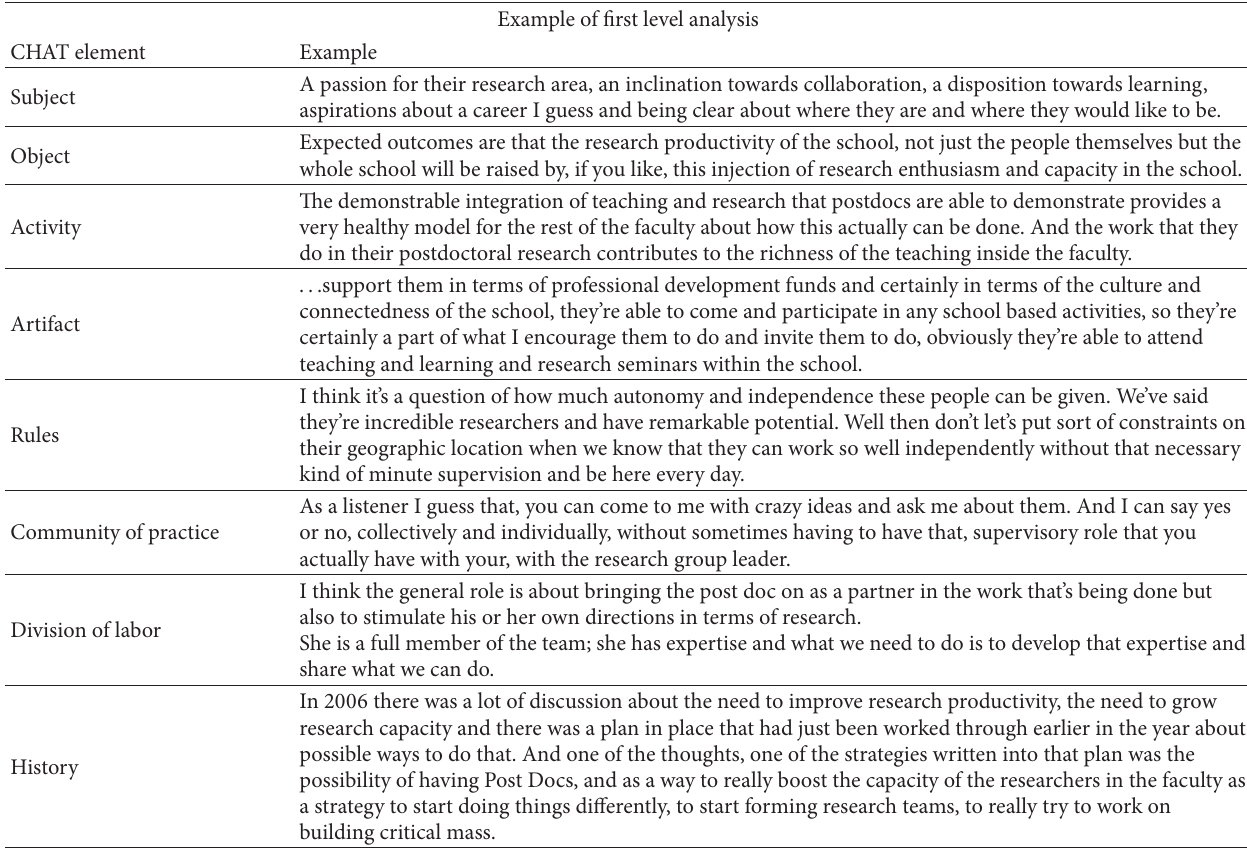
Table 1: Example of the first level